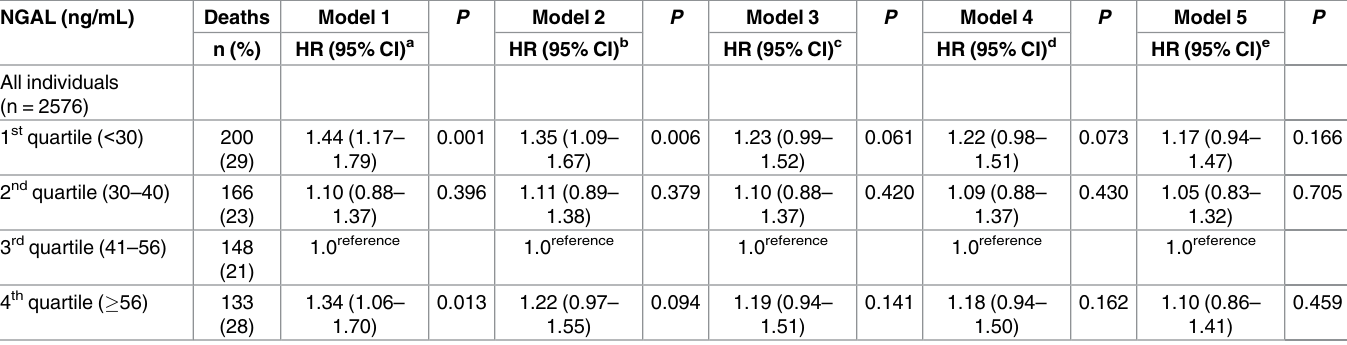
Table 5. Hazard ratios (HR) for death from all causes according to NGAL (eGFR > 60 ml/min/1.73 m 2 ). NGAL (ng/mL)